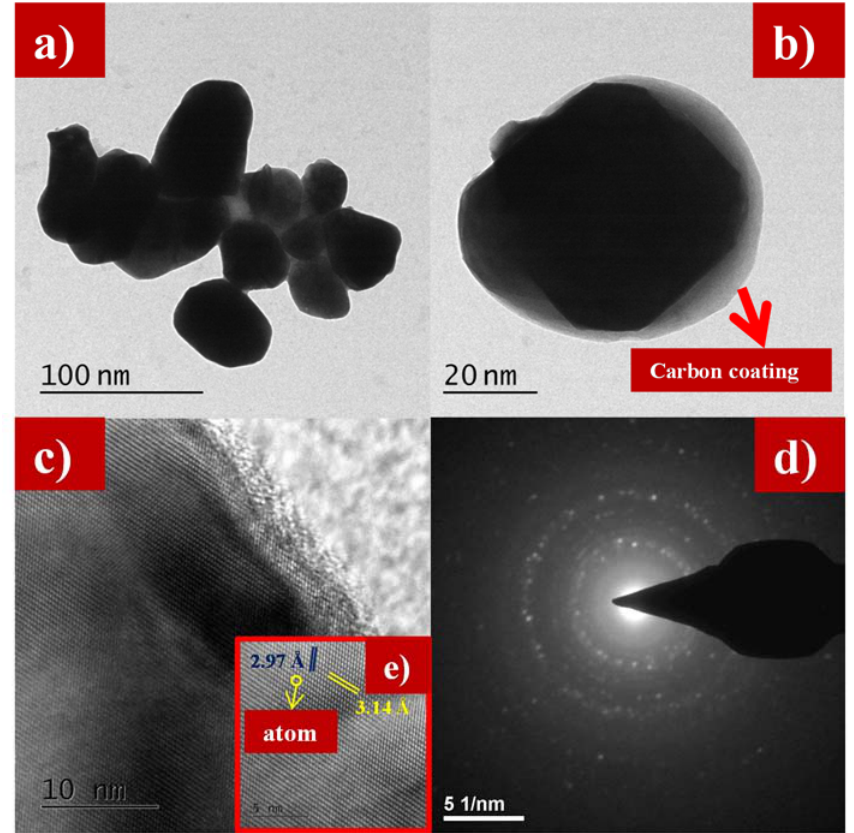
Figure 5. ( a , b ) Transmission electron microscope (TEM) images at 100 nm and 20 nm, ( c ) lattice fringes, ( d ) selected area electron diffraction SAED, and ( e ) individual atom of as-synthesized LFS@ESM.